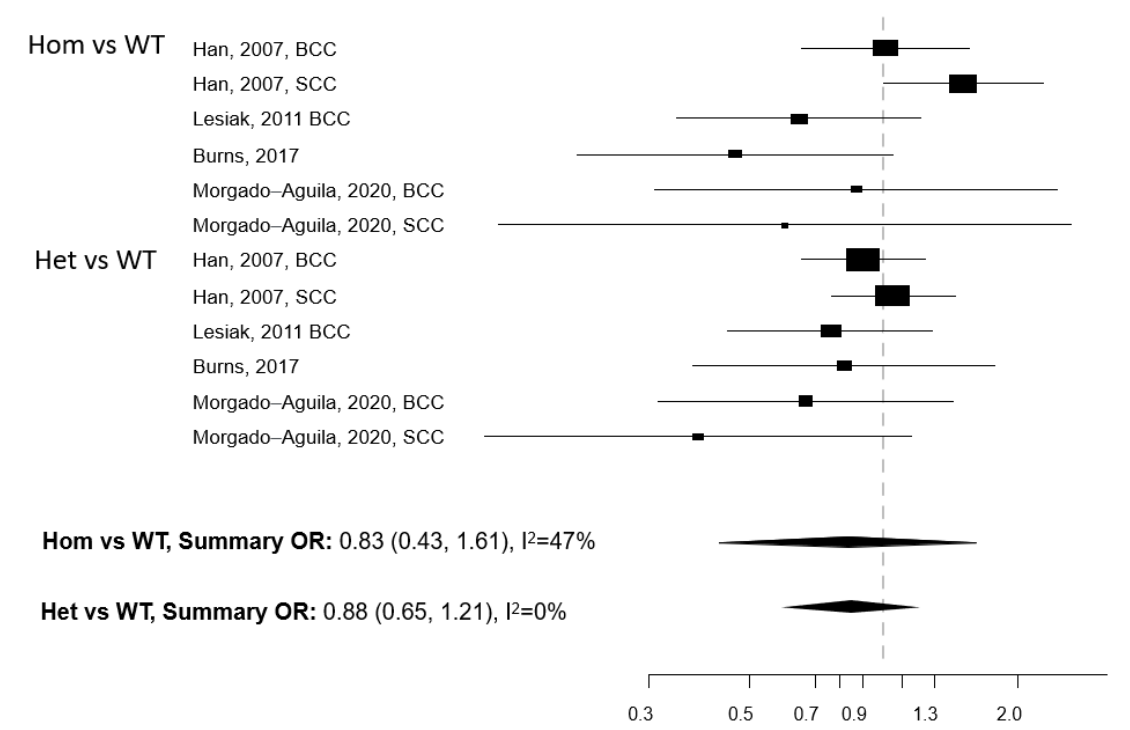
Figure 4. Forest plot for the association between the Bsm1 polymorphism of the vitamin D receptor ( VDR ) gene and the risk of non-melanoma skin cancer. BCC: basal cell cancer. SCC: squamous cell cancer. RR: relative risk. Hom: homozygous. Het: heterozygous. WT: